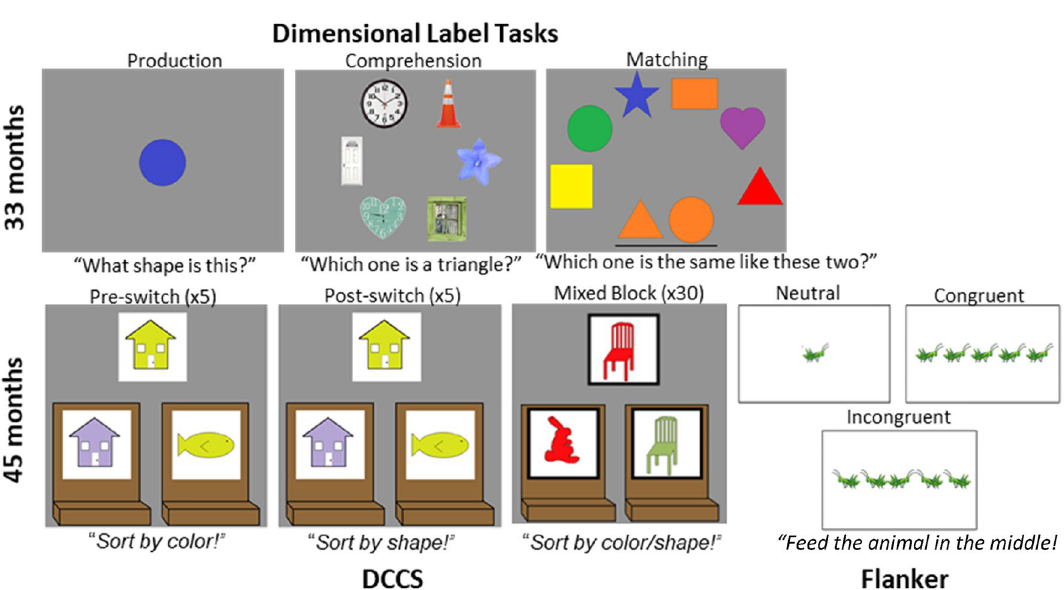
Figure 2. Tasks completed at 33 and 45 months. (33 months) Children completed production, comprehension, and matching tasks for colors, shapes, and embedded shapes. (45 months) Children completed DCCS and Flanker tasks, as well as production and comprehension tasks for colors and